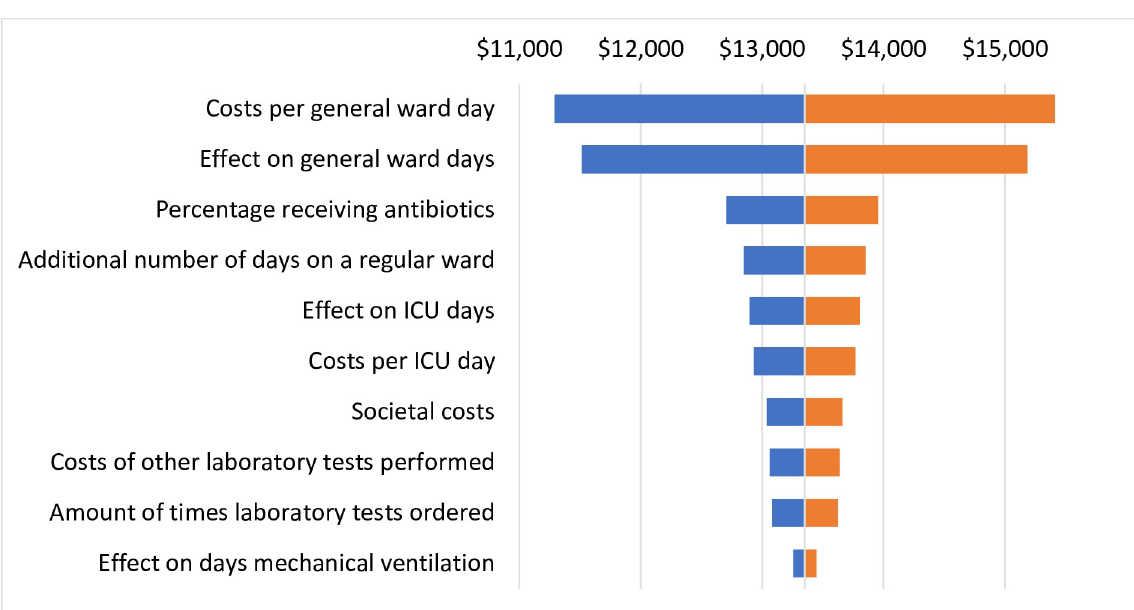
PLOS ONE | https://doi.org/10.1371/journal.pone.0214222 April 23,